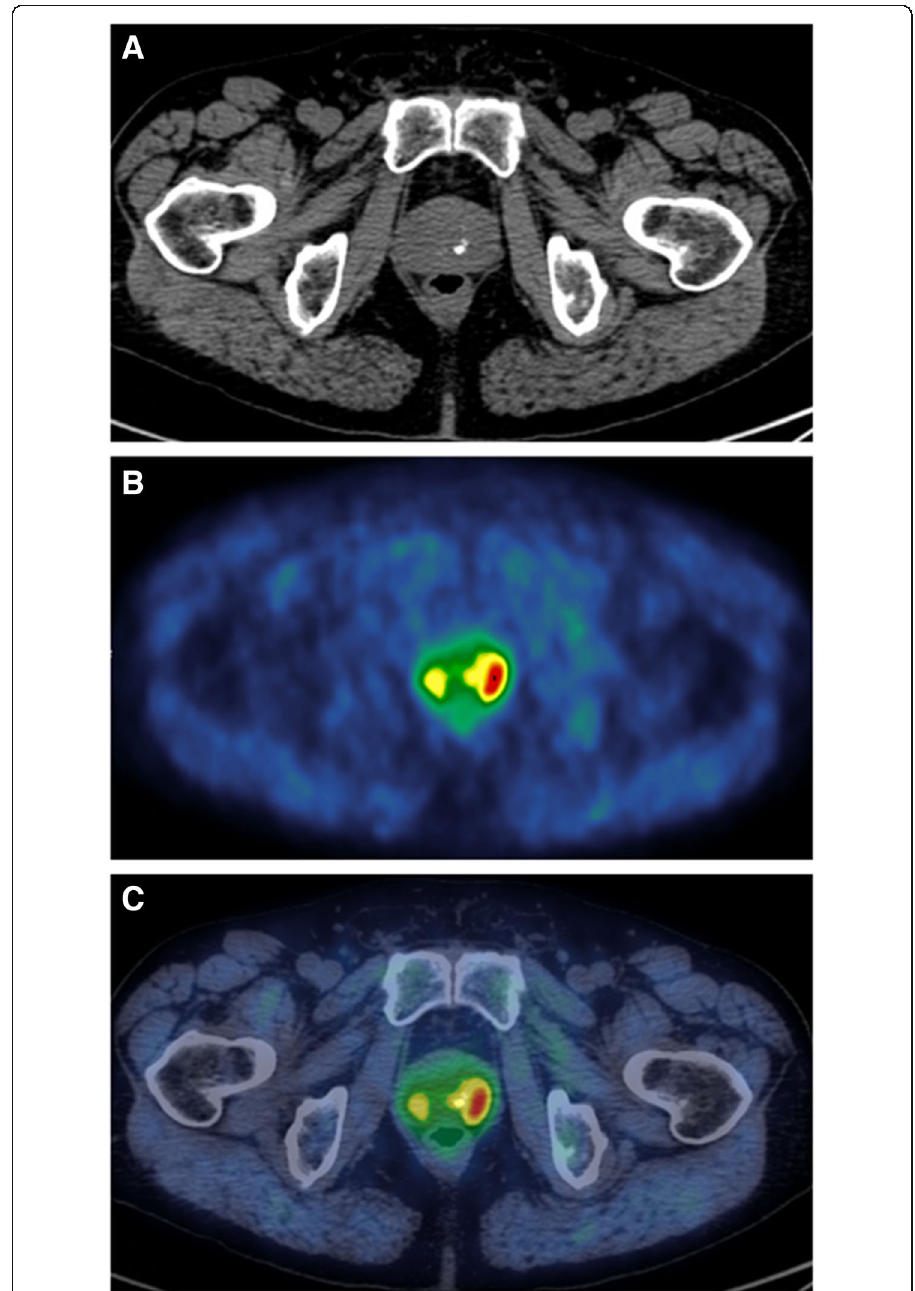
Fig. 1 Focal uptake detected on the periphery of the left prostatic lobe. a CT scan; b 11C-choline PET scan; c 11C – choline PET/CT fused